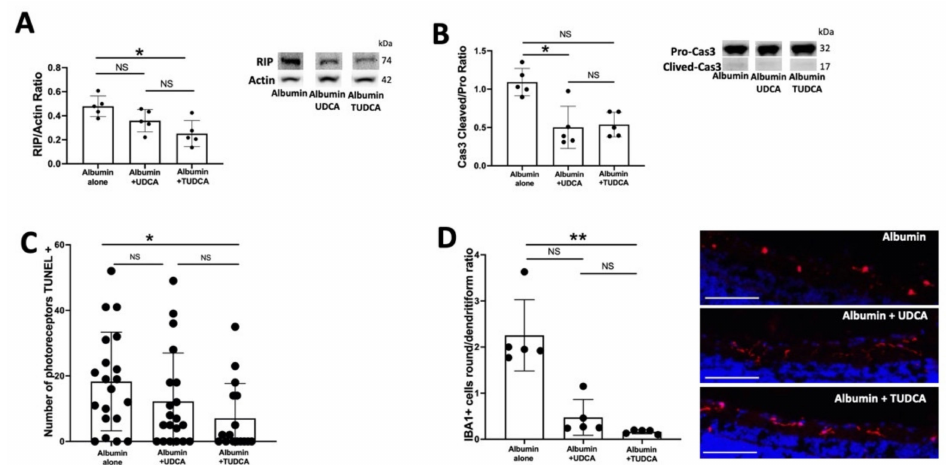
Figure 2. UDCA protects from albumin-induced cell death ex vivo. Rat retina explants were treated by albumin 12 mg/mL or albumin and UDCA or TUDCA 10 ng/mL and cultured 6 h. ( A ) Western blotting quantification. Receptor-interacting protein (RIP)/actin ratio was lower in retinas treated by UDCA or TUDCA, with only significance between for TUDCA vs. albumin. No significant difference was seen between UDCA and TUDCA. ( B ) Cleaved/pro-Caspase 3 ratio was lower in retinas treated by UDCA or TUDCA with only significance between for UDCA vs. albumin. No significant difference was seen between UDCA and TUDCA. ( C ) Number of photoreceptors TUNEL + was reduced in retinas treated by UDCA and TUDCA compared to albumin alone, with only significance for TUDCA. No significant difference was seen between UDCA and TUDCA. ( D ) Round/ramified ionized calcium-binding adapter molecule (IBA1)-positive cells (red) ratio was lower in UDCA or TUDCA-treated retinas, with significance only between for TUDCA vs. Albumin. No significant difference was seen between UDCA and TUDCA ( p = 0.2). Scale bars: 100 µ m. The